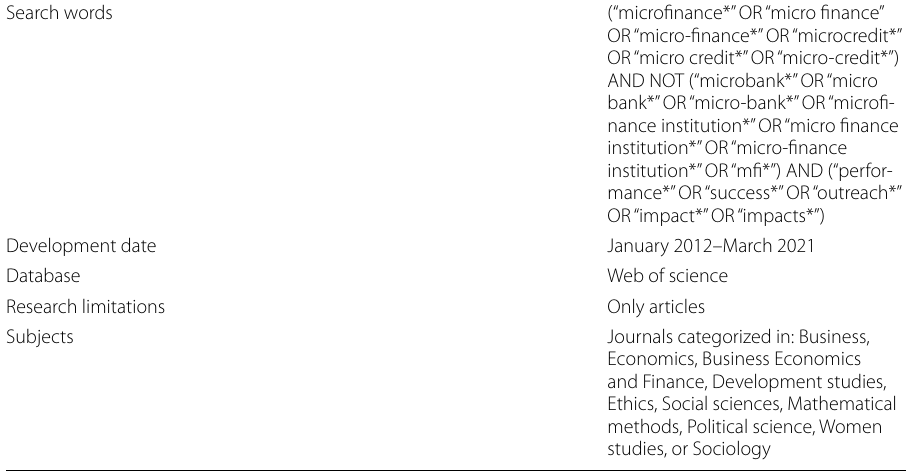
Table 2 Data collection